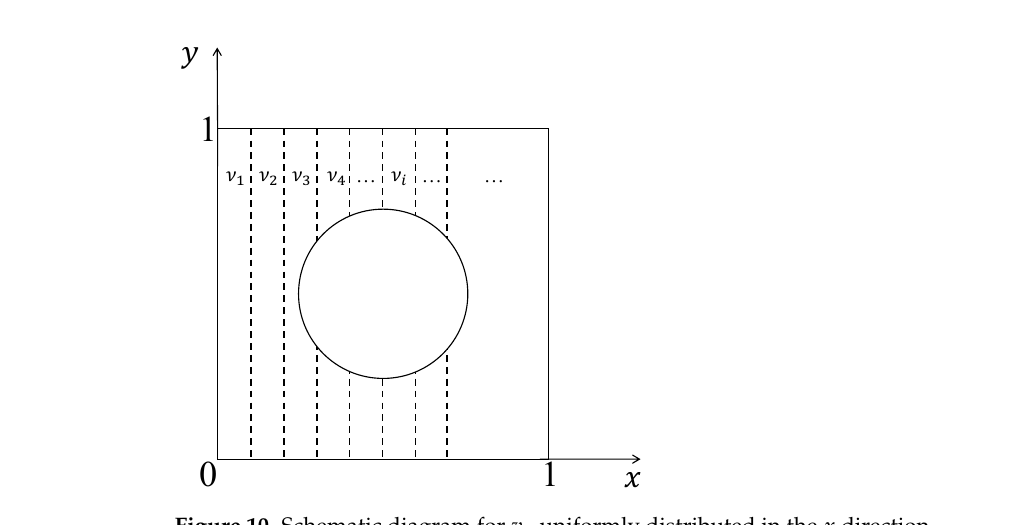
( b ) Figure 11. ( a ) Training loss versus epoch ( 𝑛 = 10 ); ( b ) Converged 𝜈 (cid:3041) ( 𝑛 = 5, 10 , and 15 ) obtained from the PINN in the 𝑥 direction.